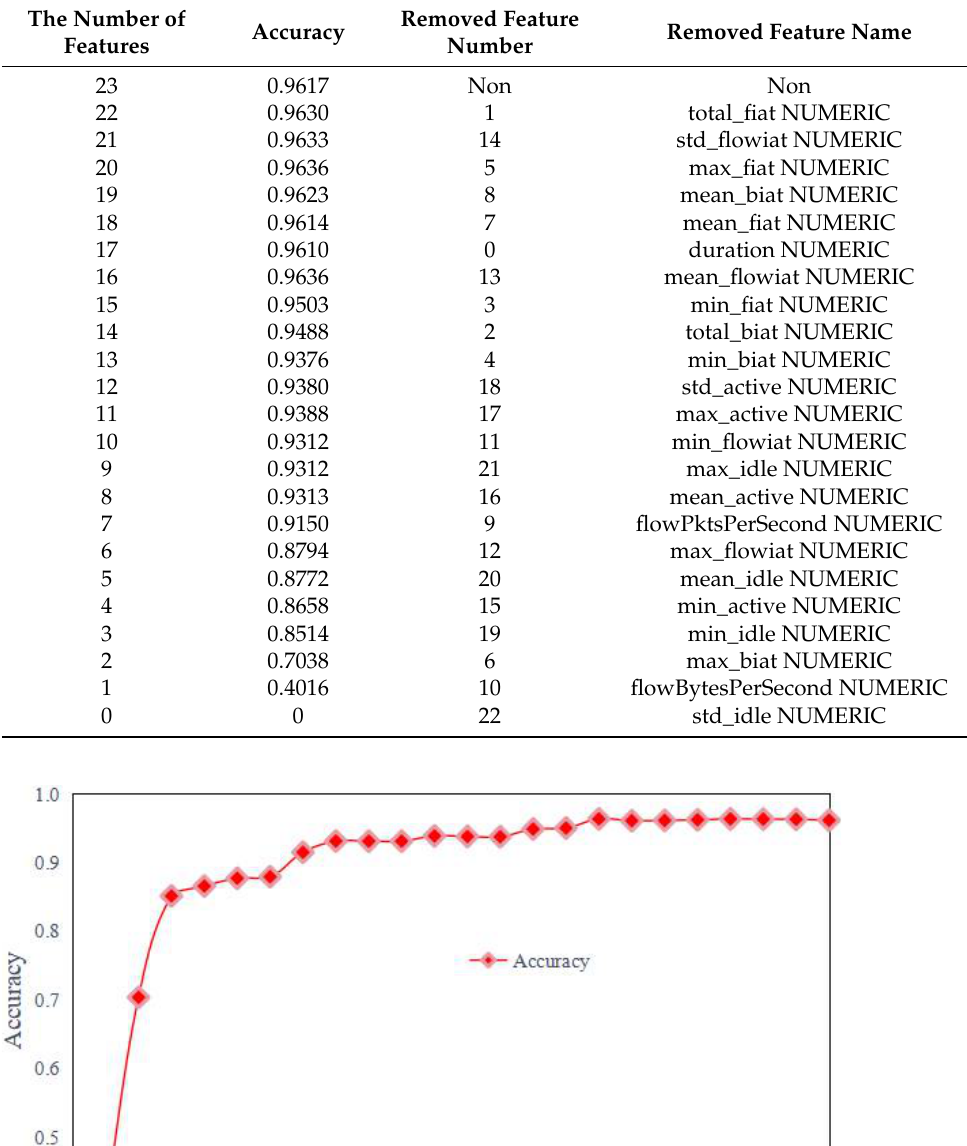
Table 4. The effect of the features number on the accuracy of the model.